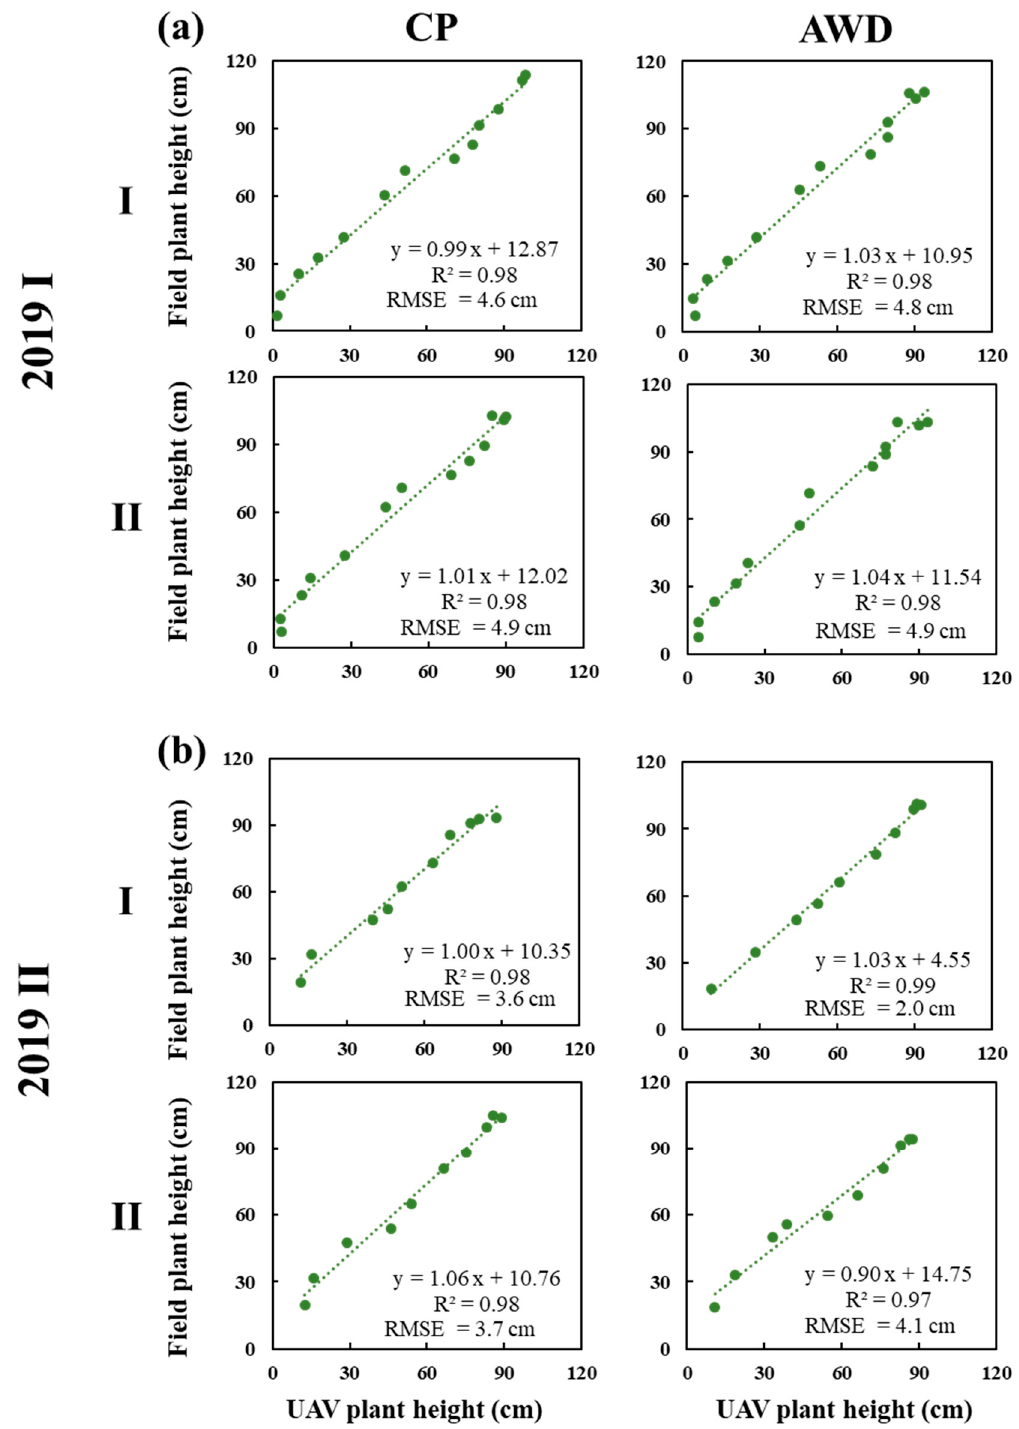
Figure 7. Comparison between the mean plant height derived from UAV measurements and plant height measured manually of TNG71 rice variety in the field under different water treatment (conventional planting (CP) and alternative wet and dry (AWD)) in ( a ) the first crop season; and ( b ) the second crop season.